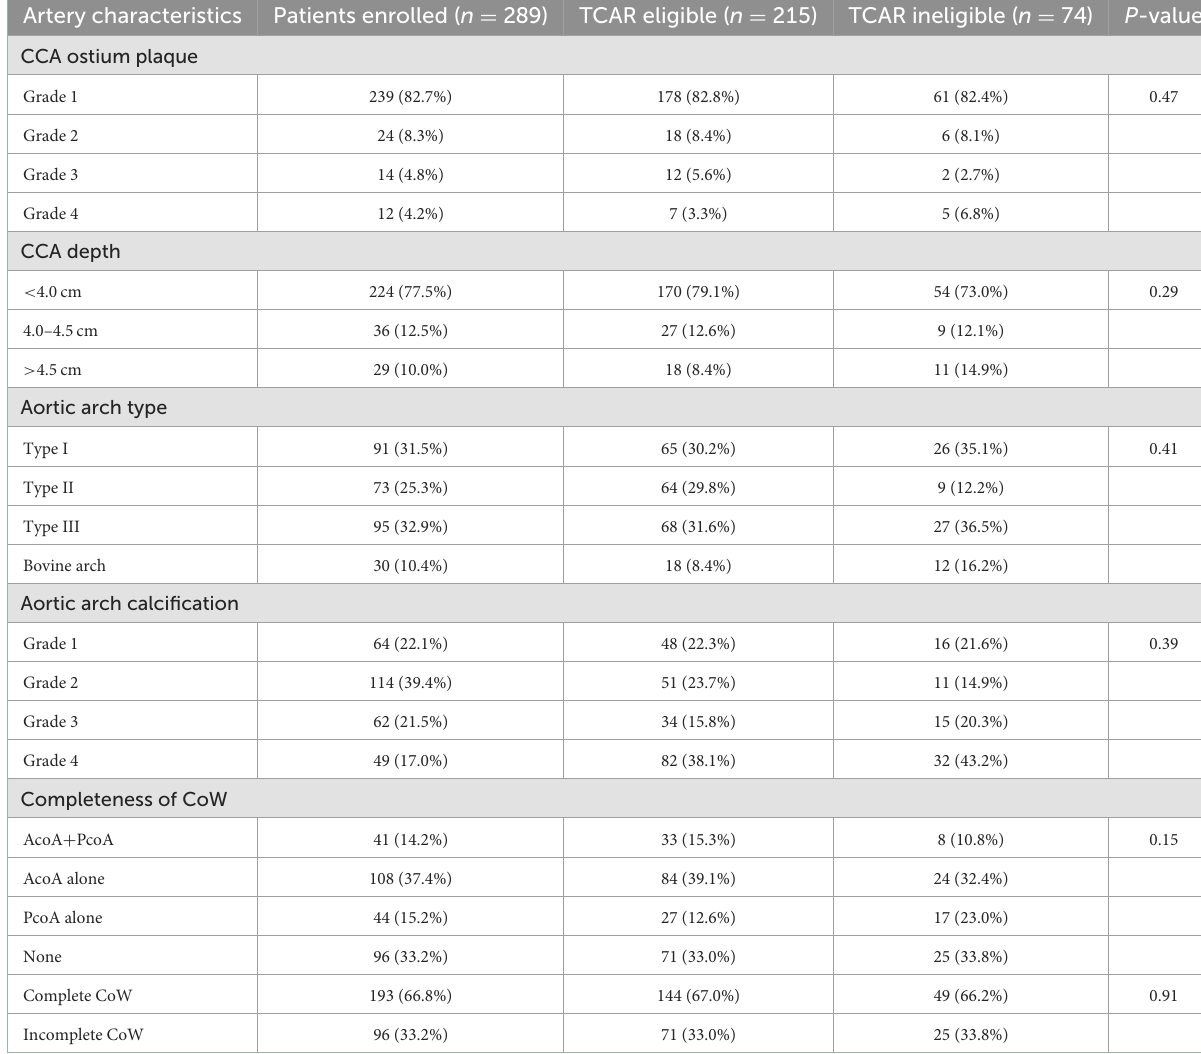
TABLE 2 Aortic arch and carotid-intracranial artery characteristics of patients who were eligible and ineligible for TCAR. Artery